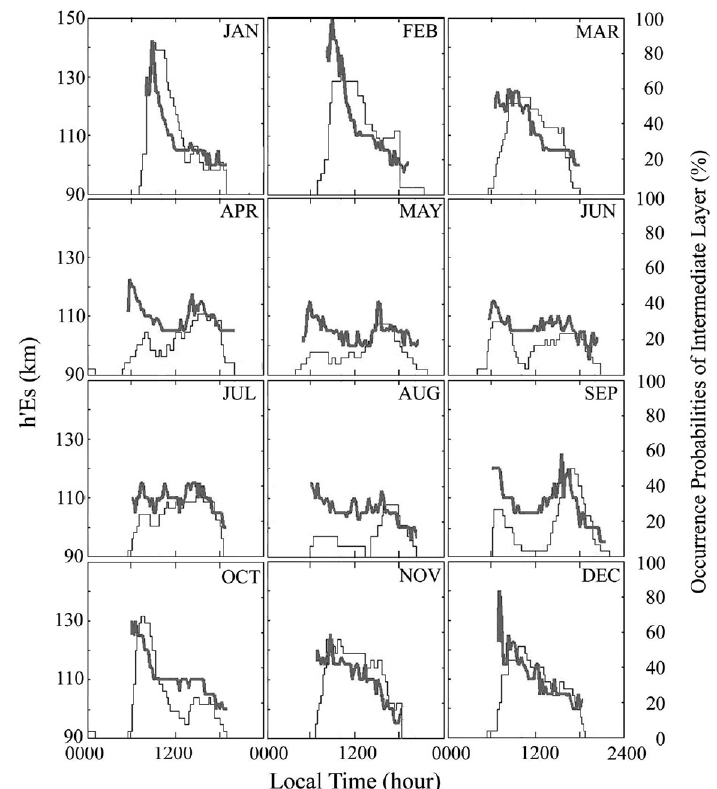
Fig. 3. Median values of the h 0 Es (bold line) of the intermediate layer in January–December, respectively. The histogram in the background is the as- sociated occurrence probability of the intermediate layers. The single peak ( > 50%) of occurrence probability ap- pears in spring and winter, while the double peak ( < 50%) appears in sum- mer and autumn. Additionally, the one descent of the layer occurs in the single- peak months, while the two descents appear in the double-peak